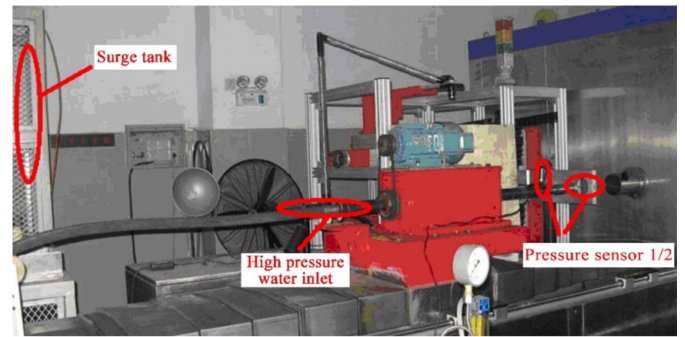
Figure 3. Pressure measurement system.